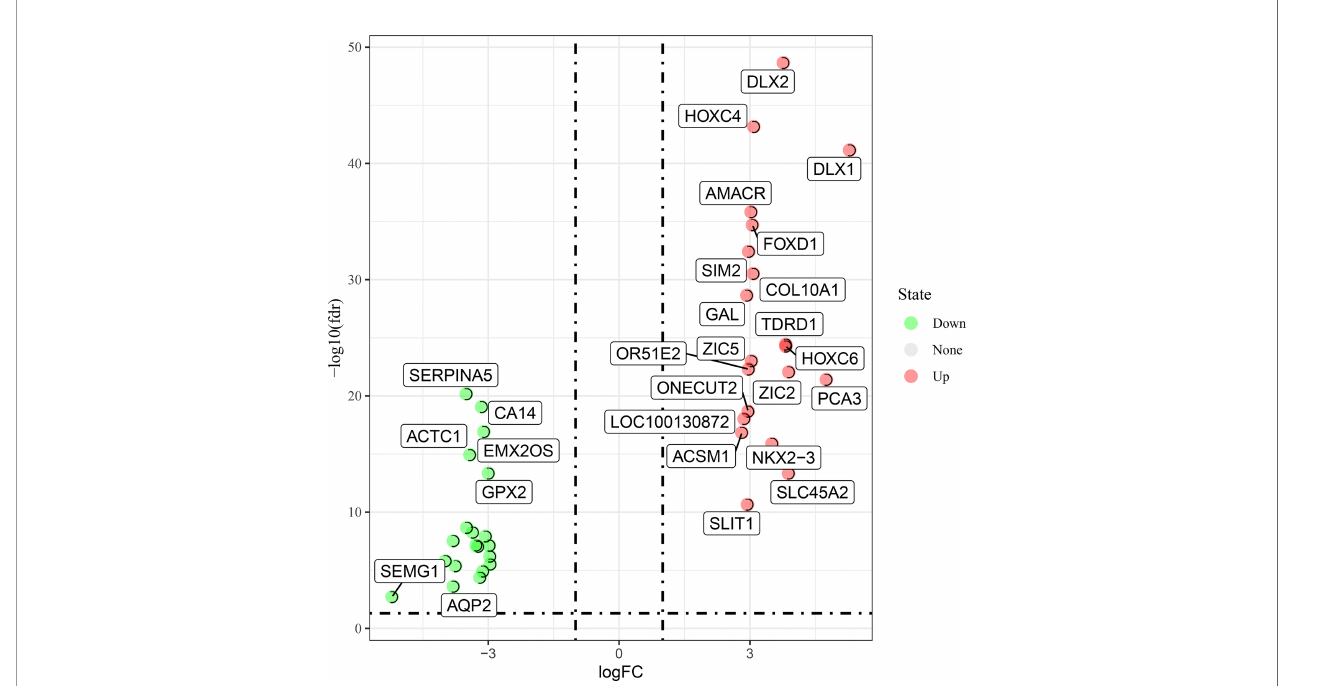
FIGURE 1 | Top up- and downregulated expression genes of prostate cancer (PC) cases were characterized in the volcano